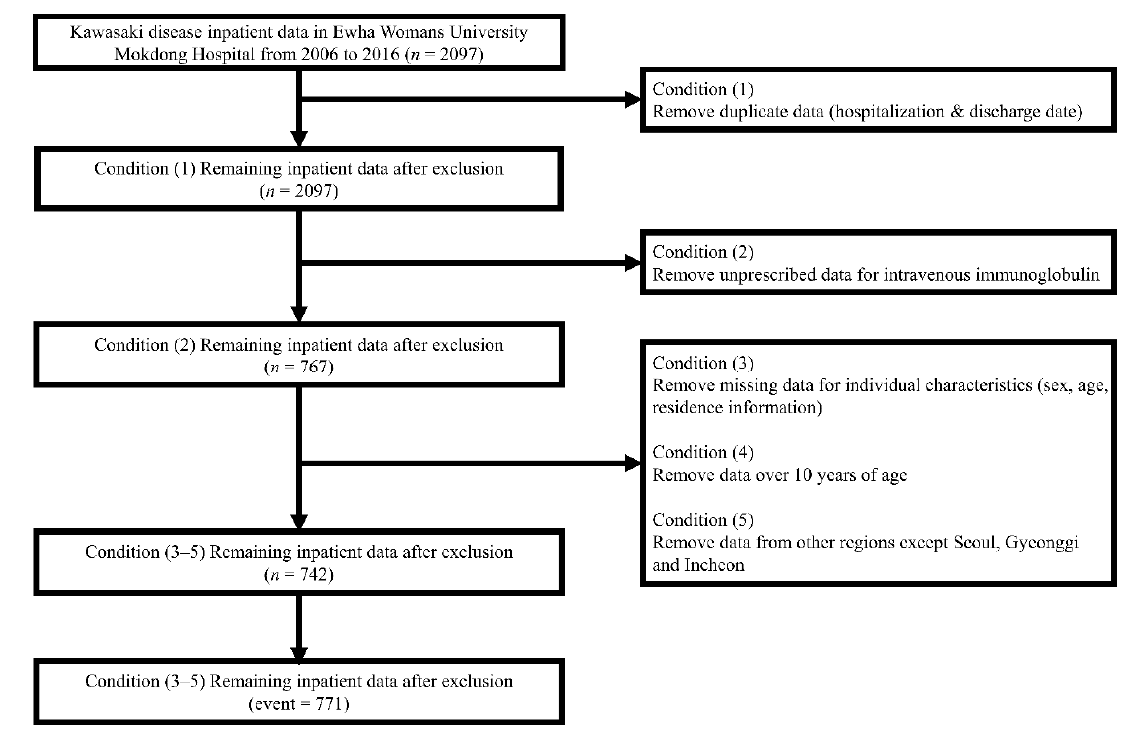
Figure 1. Defining Kawasaki cases at Ewha Womans University Mokdong Hospital during 2006–2016. Table 1. Descriptive statistics on the characteristics of Kawasaki disease patients in Ewha Womans University Mokdong Hospital during the study period of